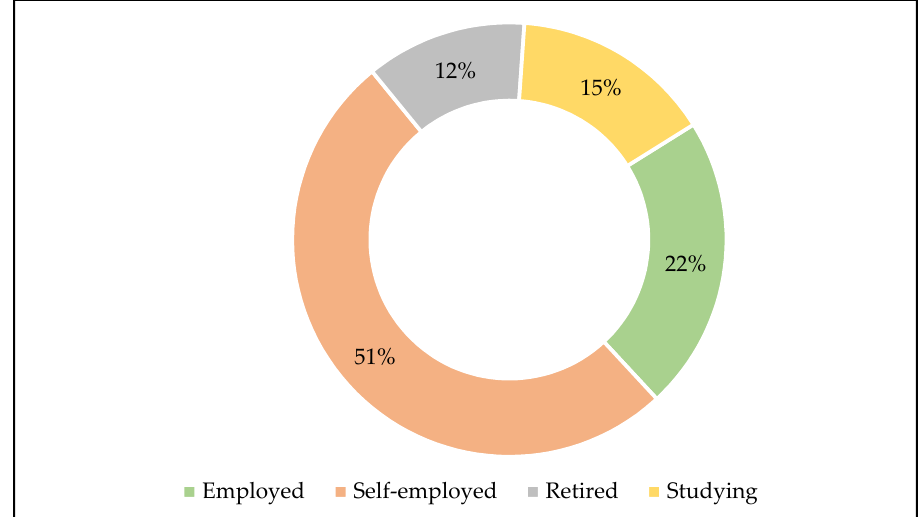
Figure 3. Livelihood activities.